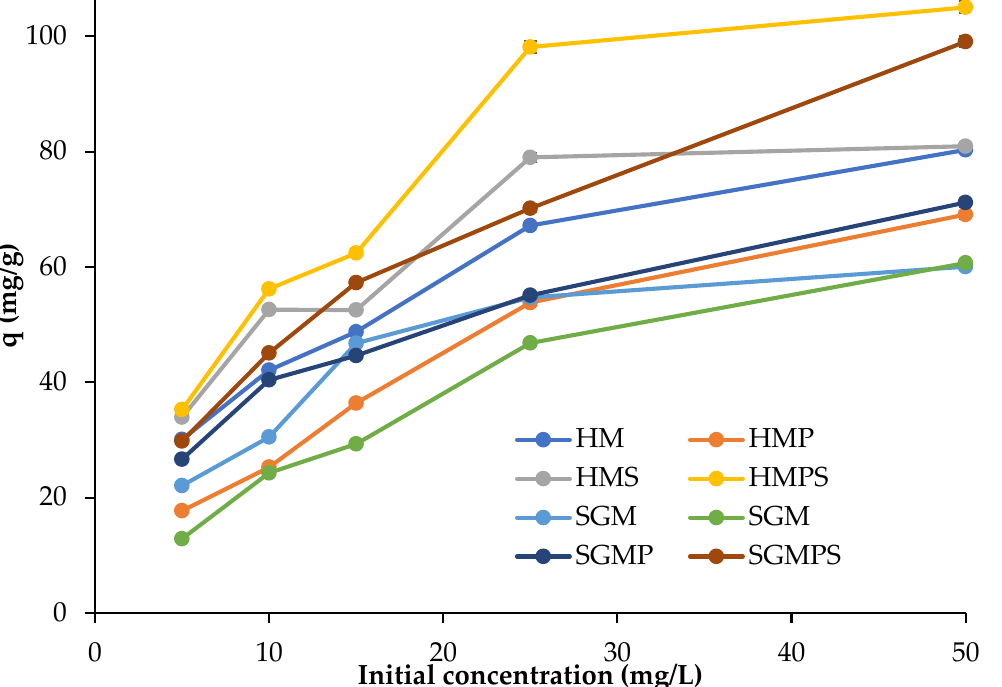
Figure 2. Effect of initial concentration on direct violet 51 adsorption by various materials.